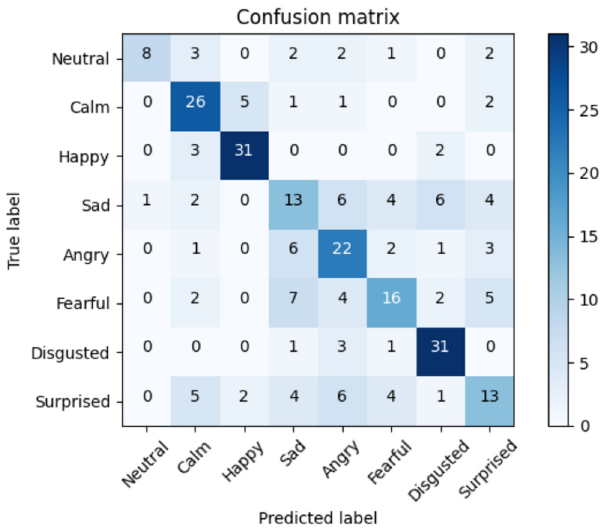
Figure 13. Average confusion matrix for the SVM algorithm. Accuracy = 76%.